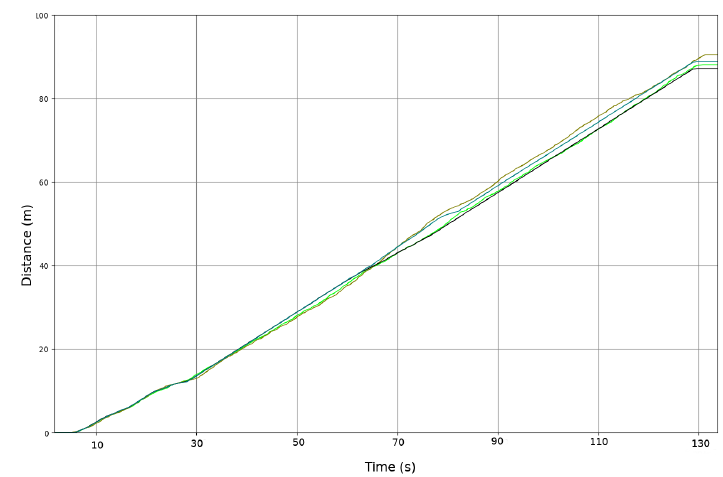
Figure 8. Calculation of total distance traveled based on Doppler and odometric sensors in a non- slip area. Black and blue displacement based on odometric sensor. Green and brown displacement based on radar speed sensor.